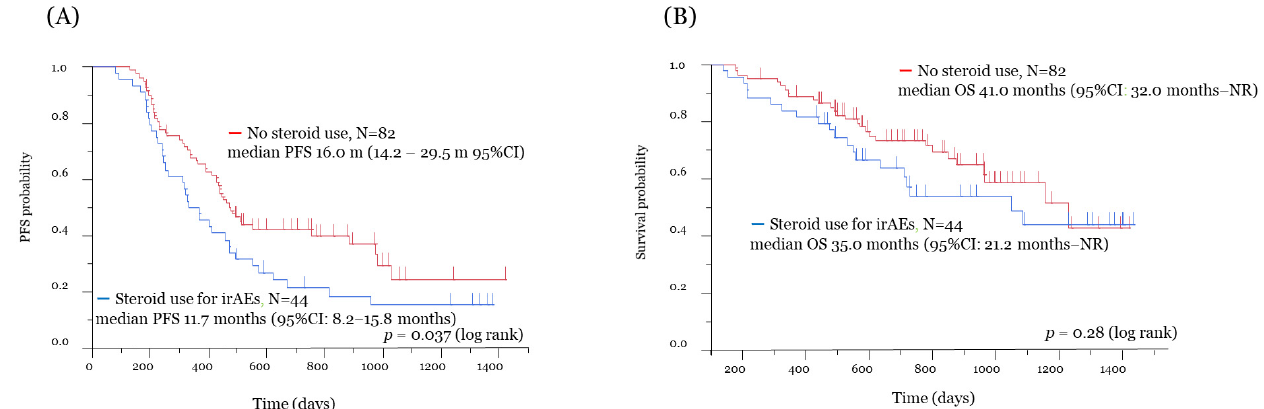
Figure 2. Kaplan–Meier survival analysis for the systemic steroid use for irAEs. The figures show Kaplan–Meier curves for PFS ( A ) and OS ( B ) in the systemic steroid use for irAE cohort (blue line) and the no steroid use for irAE cohort (red line). Survival analysis with ICI treatment: significant difference in PFS and no significant difference in OS. irAE, immune-related adverse event; PFS, progression-free survival; OS, overall survival; NR, not reached. Figure 3 Kaplan–Meier survival analysis according to systemic steroid use for any reason (A) (B)